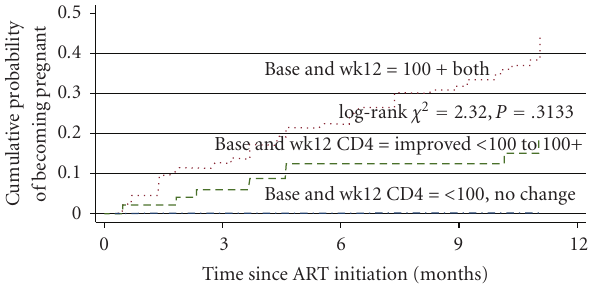
Figure 1: Probability of pregnancy while on ART among women, 15–45